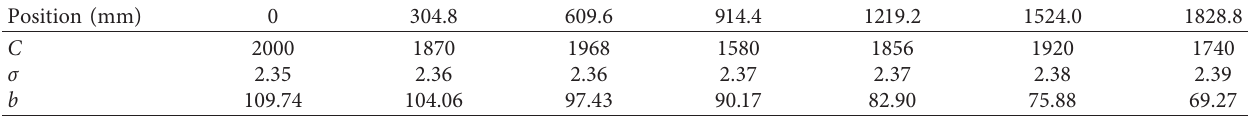
Table 3: Model training results.